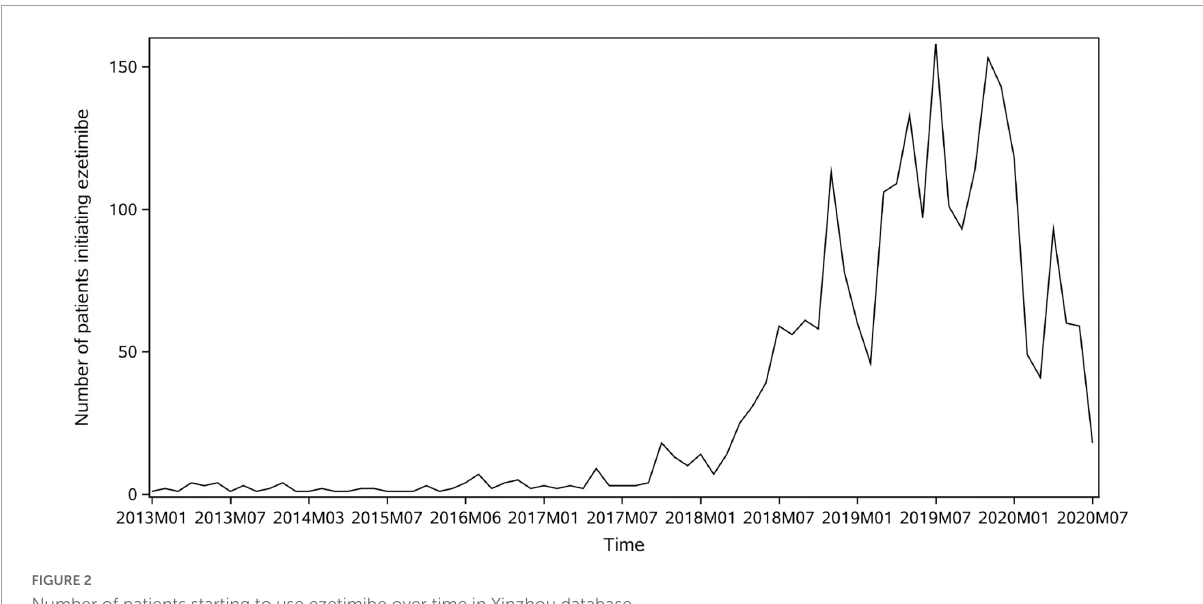
FIGURE2 Number of patients starting to use ezetimibe over time in Yinzhou database.